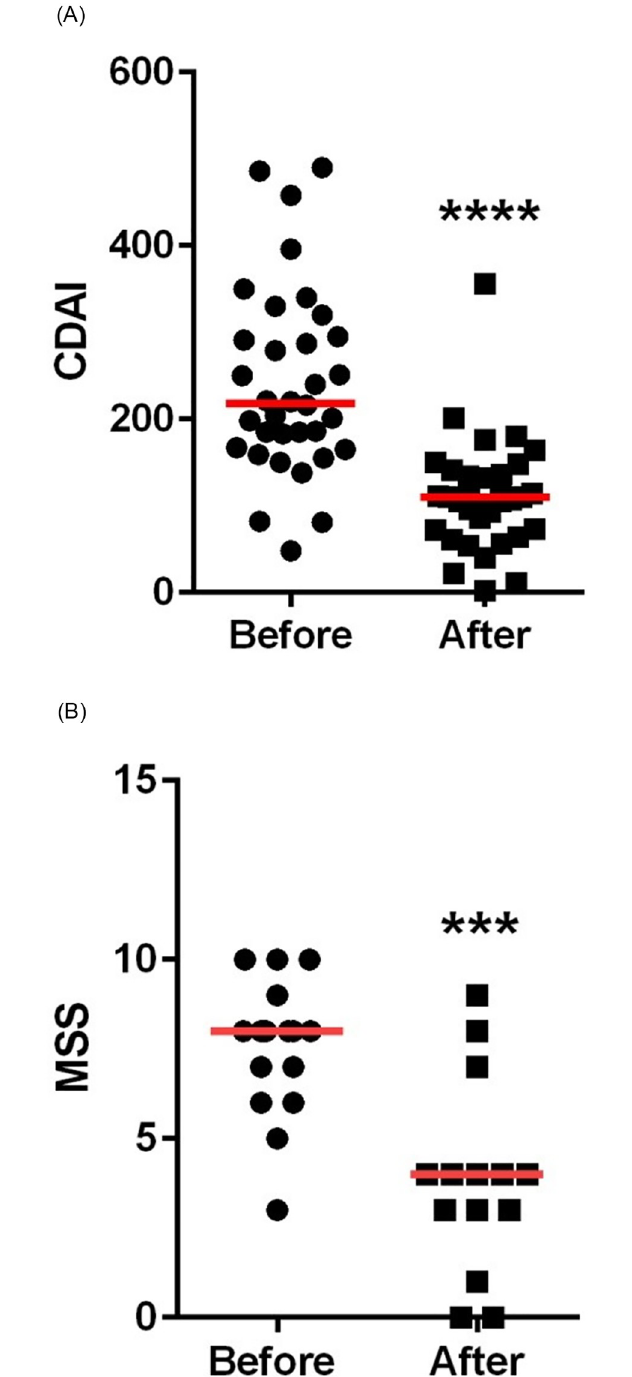
Fig 1. A : The trend of CDAI values in the CD group before and after 12 weeks of therapy. B : The trend of MSS values in the UC group before and after 12 weeks of therapy.